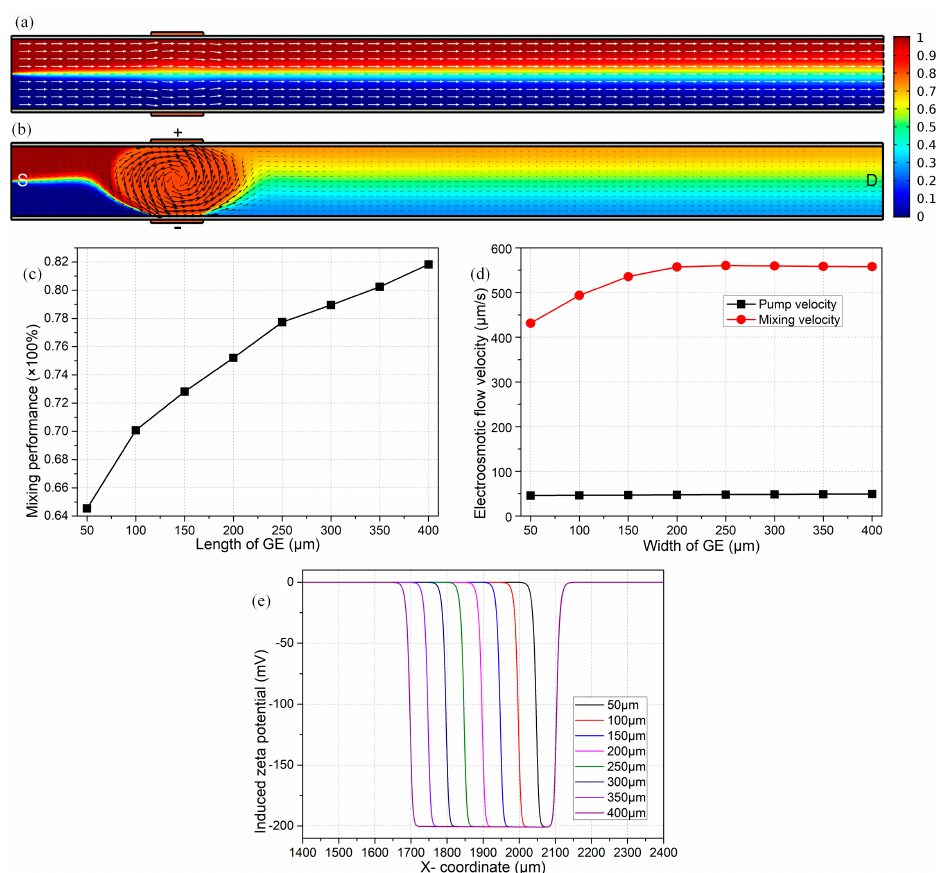
Figure 2. Effect of the length of gate terminal L G on the device performance in terms of dual functionalities. ( a , b ) An arrow and surface plot of the electroosmotic flow field and analyte concentration distribution in the straight microchannel. ( a ) Passive mixing of incoming samples carried by a forward electroosmotic pump flow rate of 47 μm/s under Vs = 30 V in the absence of gate voltage supplies, where merely the molecular diffusion effect in the vertical concentration gradient across the phase interface between the two co-flowing laminar streams occurs and is responsible for the passive mixing process, resulting in a poor mixing index of 27.8%. ( b ) Active mixing is actuated with all the DC voltage terminals turned on, in which the pump flow along the channel axial direction is caused by DC electroosmosis, and the lateral turbulent mixing flow is originated by ICEO from Bipolar DC Flow Field-Effect Transistor (B-DCFFET) with a GE length of L G = 150 μm, for given values of V S = 30 V, V G1 = − V G2 = 1500 V, giving rise to an enhanced mixing performance of γ = 72.81%. ( c ) L G -dependent device mixing performance. ( d ) Electroosmotic pump and mixing flow velocity as a function of the width of the G terminal. ( e ) Distribution of the induced zeta potential at the solution/membrane interface adjacent to the gate electrode with different L G ; the negative sign indicates positive counterionic charges in the vicinity of the negatively-polarized G terminal.